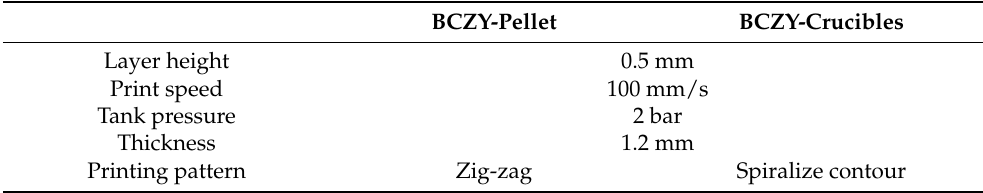
Table 1. Printing parameters used for shaping BCZY-Pellets and BCZY-Crucibles.